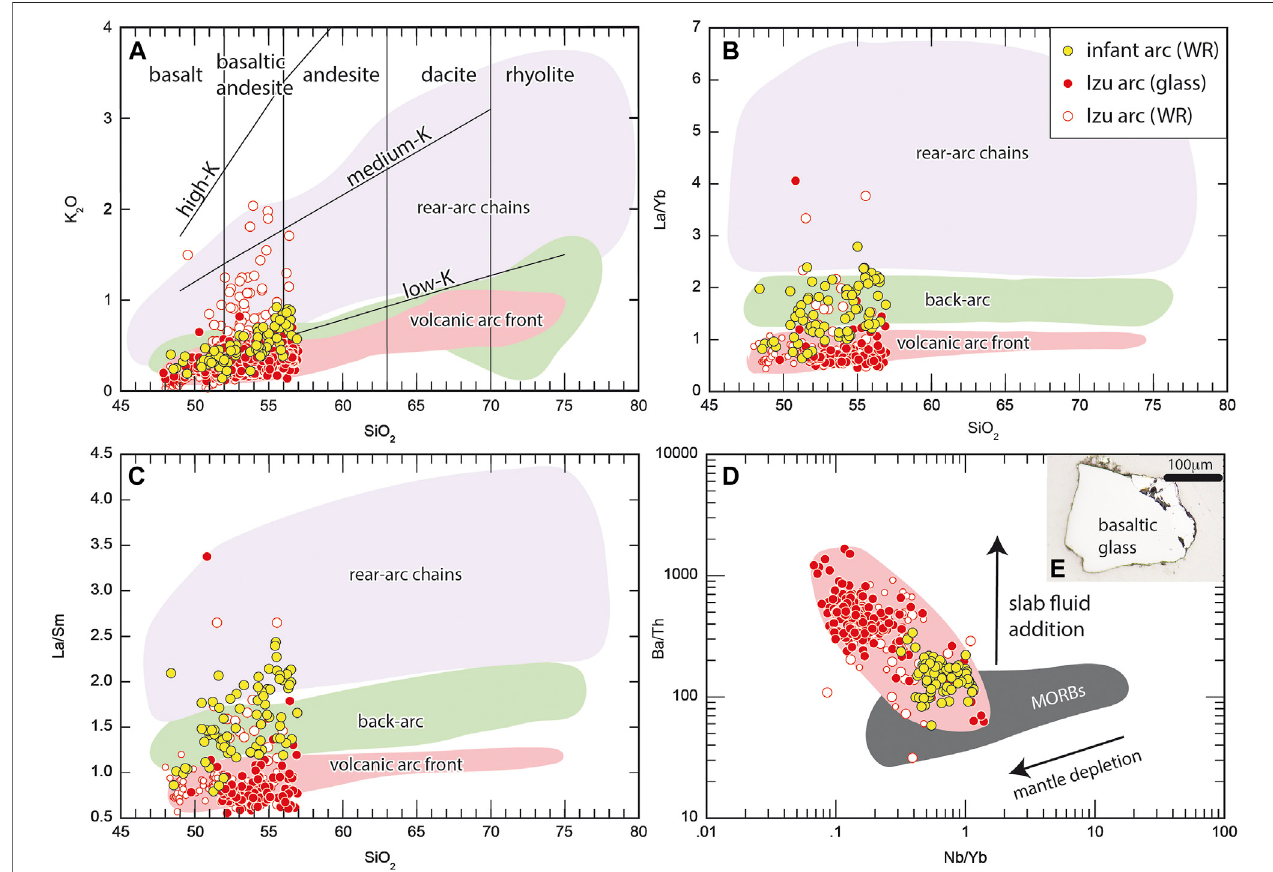
FIGURE 2 | Classi fi cation diagrams for sample provenance. (A) K 2 O, (B) La/Yb and (C) La/Sm vs. SiO 2 diagrams used to discriminate the volcaniclastics from the arcfront,theback-arcbasinandtheIzureararc(Heywoodetal.,2020). (D) Ba/Thvs.Nb/YbdiagramofPearceetal.(2005)usedtotrackthemantleandthesubduction components. (E) Photomicrographofabasalticglassshardpolishedintoepoxyfor insitu analyses.Themicrophotographwastakenunderapolarizedmicroscope.WR: whole rock. Large white circles with a red outline depict the dataset of Gill et al. (1994) and Hiscott and Gill (1992); while the smaller white circles with a red outline represent the dataset of Debari et al.